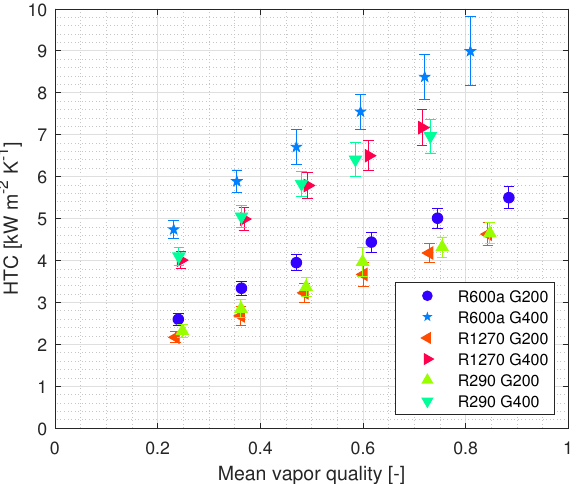
Figure 6. Condensation HTC for R290, R1270, and R600a in smooth tube mass flux (G) reported in kgm − 2 s − 1 .